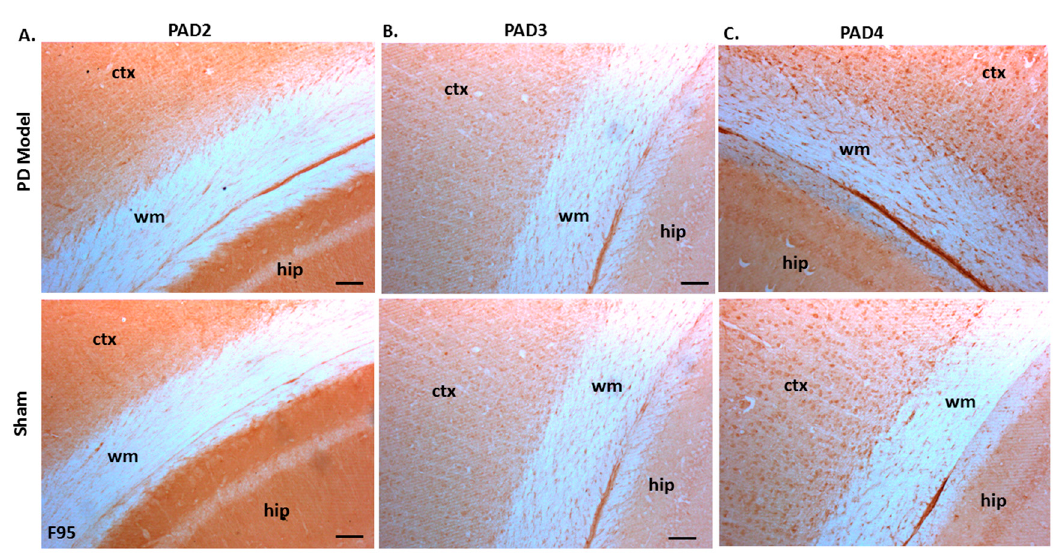
Figure 9. Deiminated histone H3 staining is increased in the cortex and dentate gyrus of pre-motor PD models. Immunohistochemical staining showed increased protein detection of deiminated histone H3 (citH3) in: ( A )) the dentate gyrus; ( B ) the cortex of the pre-motor PD models, compared with those in the control sham animals. The scale bars indicate 100 µm in all figures.